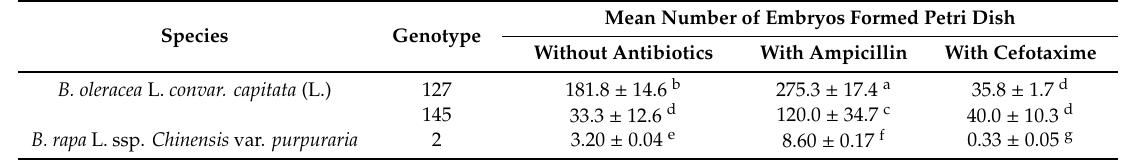
Table 1. E ff ect of antibiotics (100 mg / L) added into a culture medium on the embryogenic activity of the Brassica plants in isolated microspore culture in